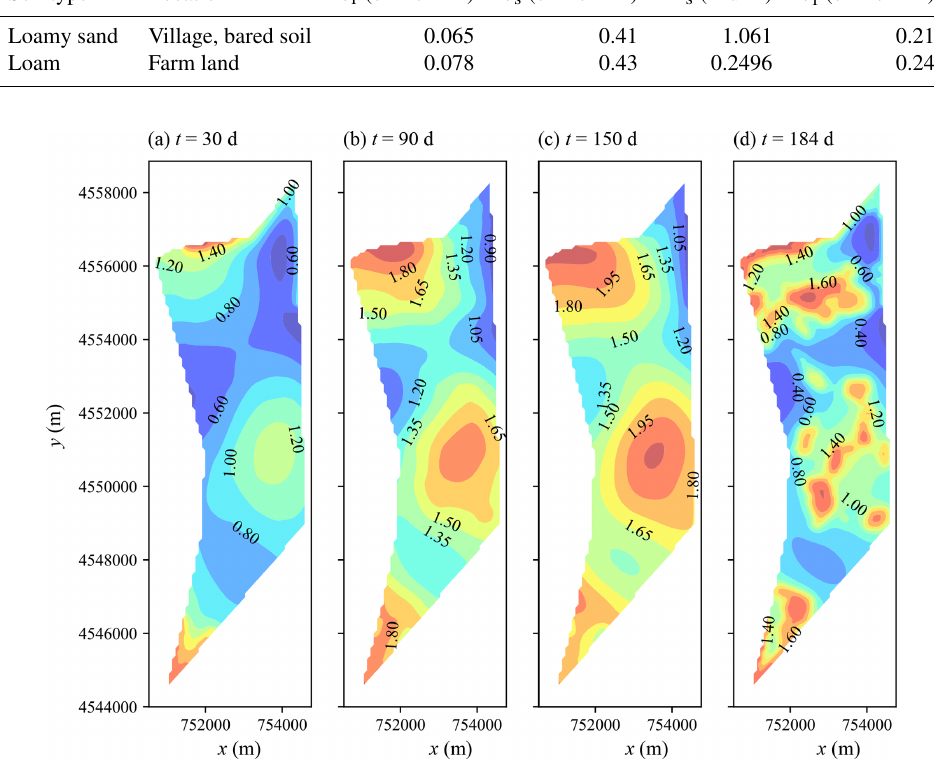
Figure 11. Spatial simulated water table depth at different output times of the real-world